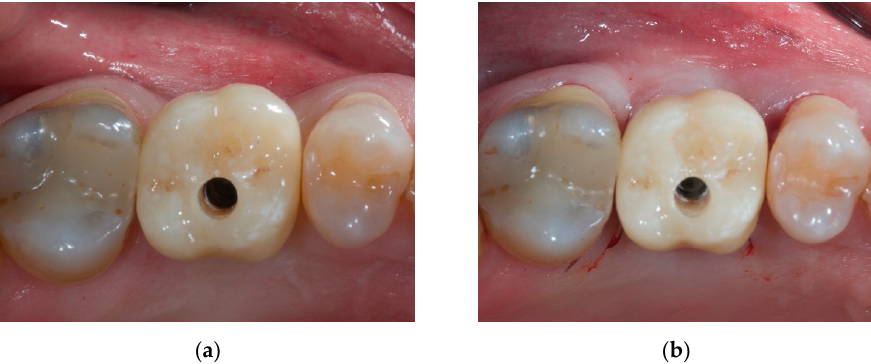
Figure 4. Occlusal view of the surgical site and the temporary screw-retained crown highlighting the volumetric differences between pre-augmentation ( a ) and post-augmentation ( b ) in the immediate post-operative period. Soft tissues were conditioned for a period of 3 months (Figure 5a–c). Once the ideal architecture of the soft tissues was achieved, the definitive restoration was delivered to the patient.